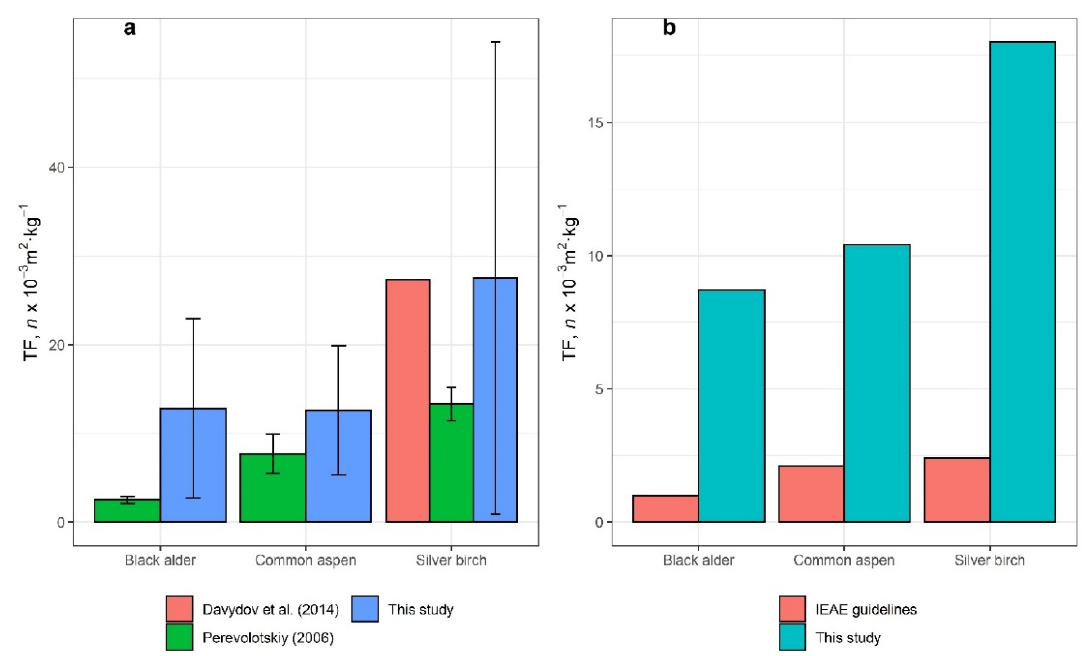
Figure 4. Comparison of transfer factors (TF) of 90 Sr from soil to the stemwood of studied tree species ( a —arithmetical means, b —geometrical means). Error bars show arithmetical standard deviations (SD) of TFs.